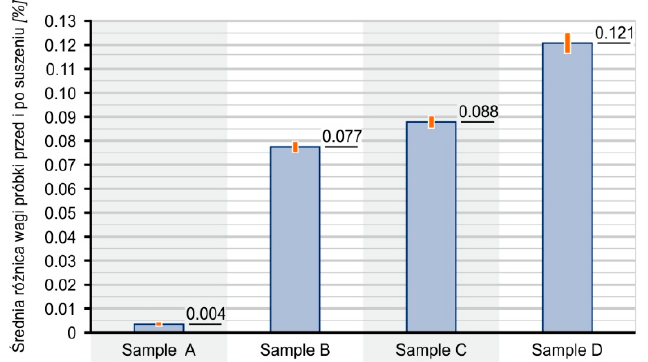
Figure 3. Water content in samples before testing in the bioreactor.